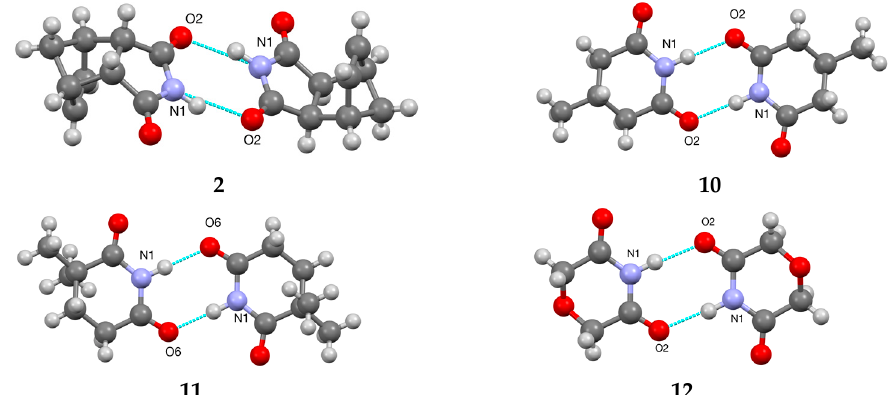
Figure 6. Hydrogen bonded R 22 (8) dimer structures for 2 , 10 , 11 and 12 .